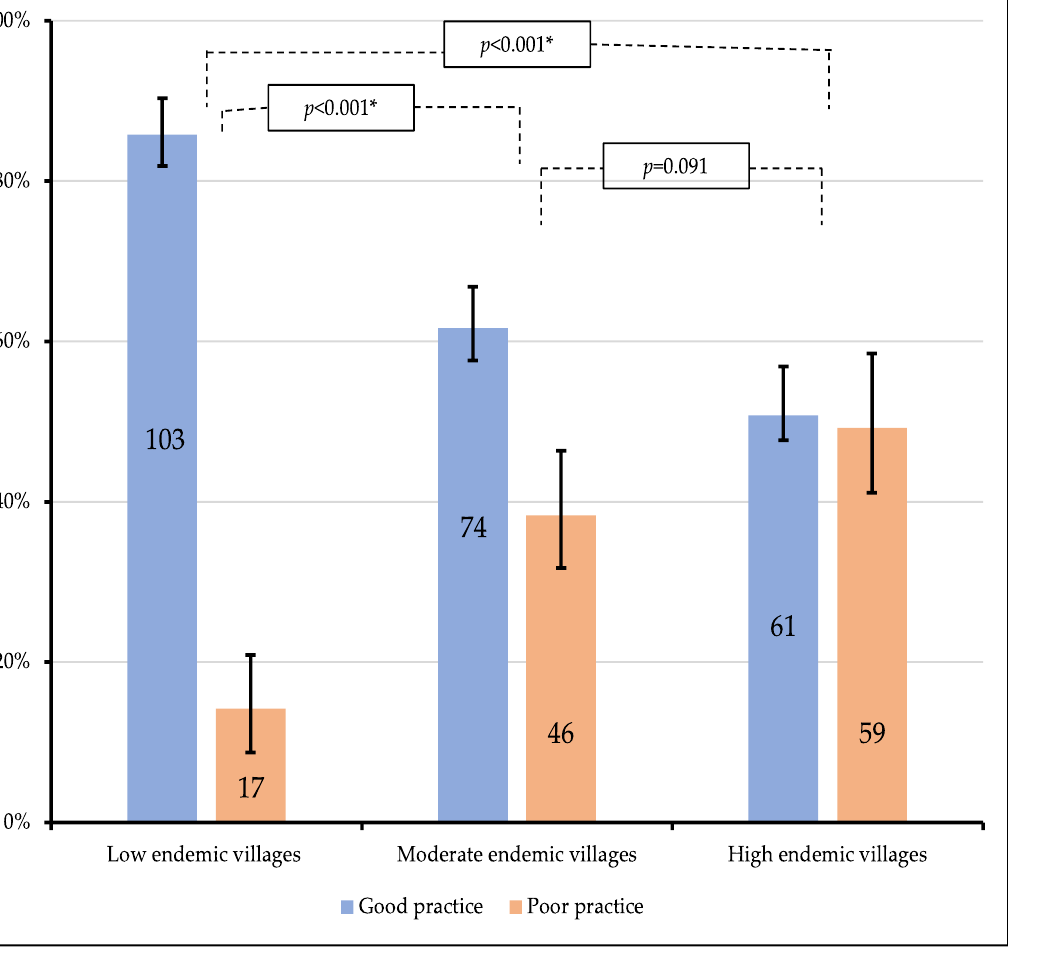
Figure 2. Malaria preventive practices among people residing in low-, moderate-, and high-malaria- endemic villages. ( p -value by chi-squared test; * statistical significance at p < 0.05; degree of freedom = 1).